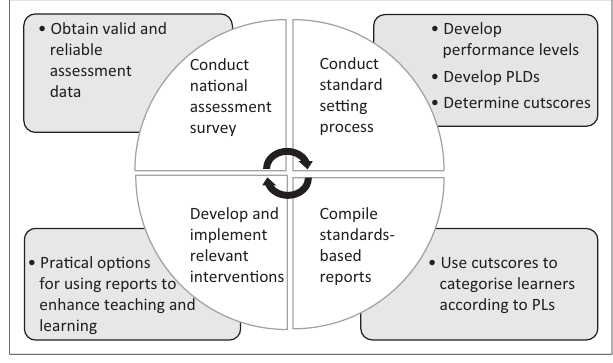
FIGURE 2: Standards-based reporting framework for national assessment surveys